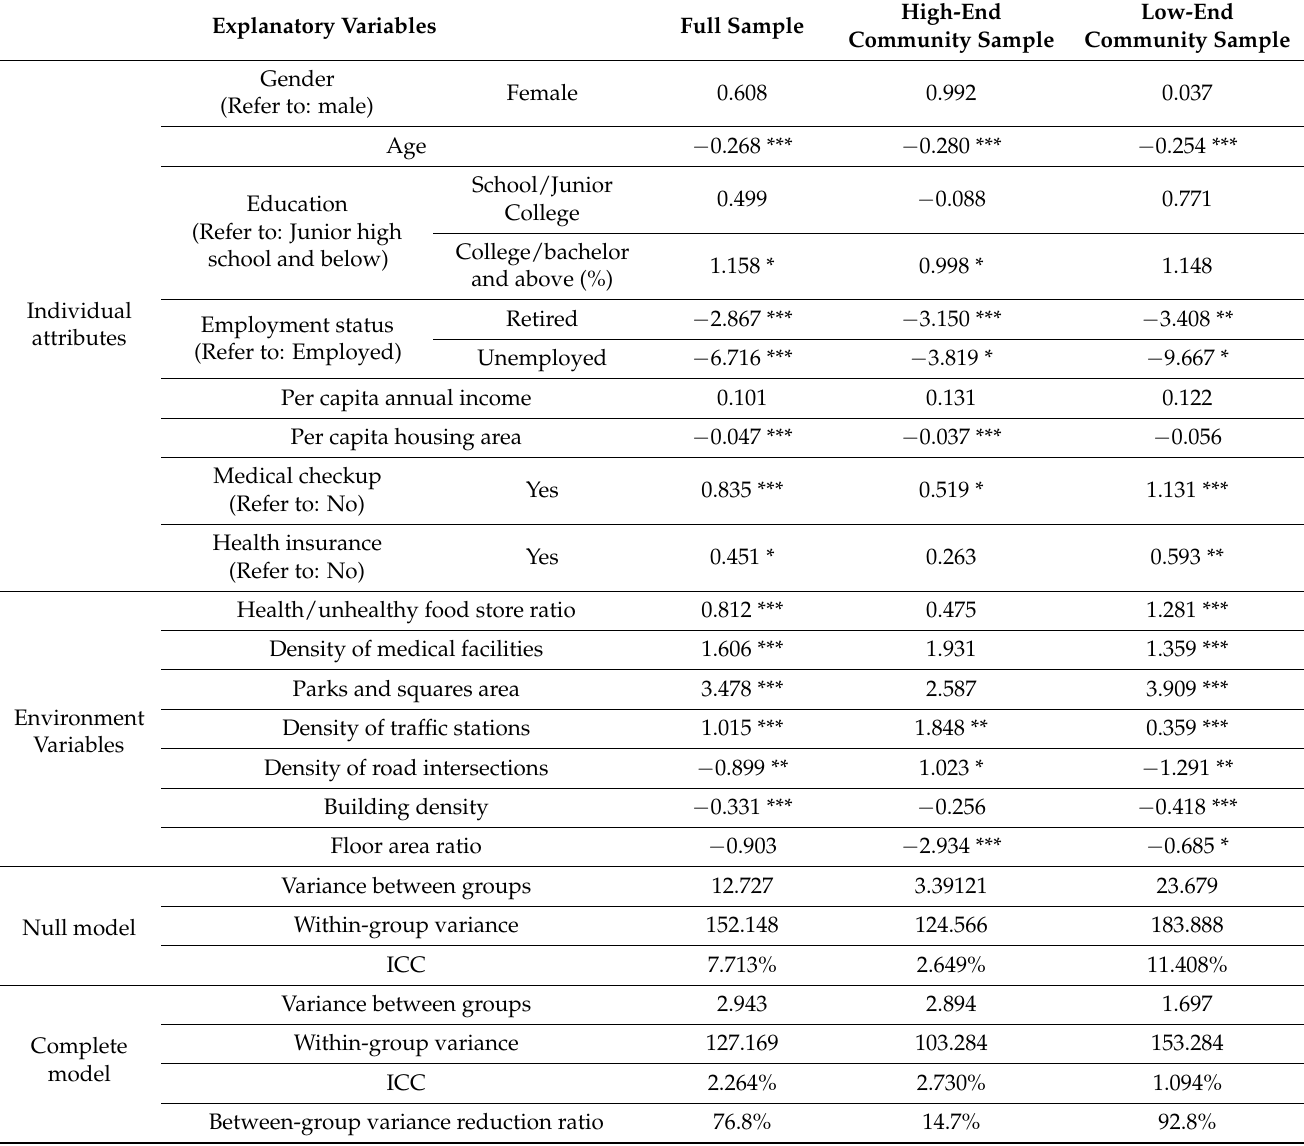
Table 4. Regression Model